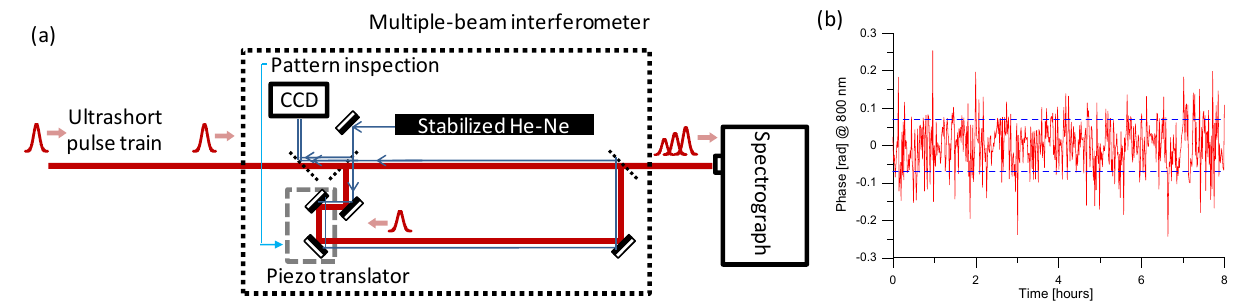
Figure 12. Schematic layout for the linear detection of the CEP drift ( a ). The variation of the actively stabilized path length provides the accuracy of the CEP measurement at 800 nm ( b